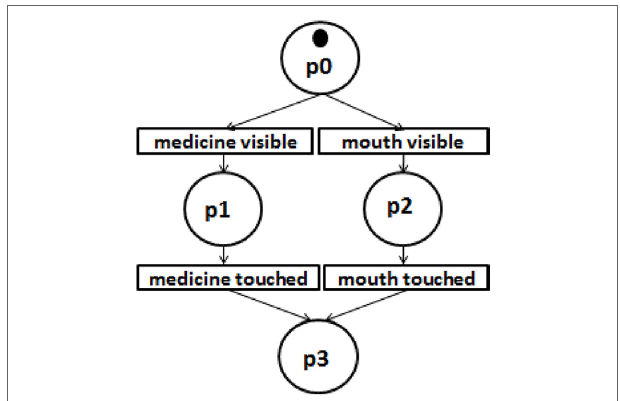
FigUre 1 | A simplified Petri net process model describing thermovisual inference of oral medicine intake: A robot can move to view medicine packages and a person’s lips, and infer that medicine intake might have taken place if both exhibit signs of recent